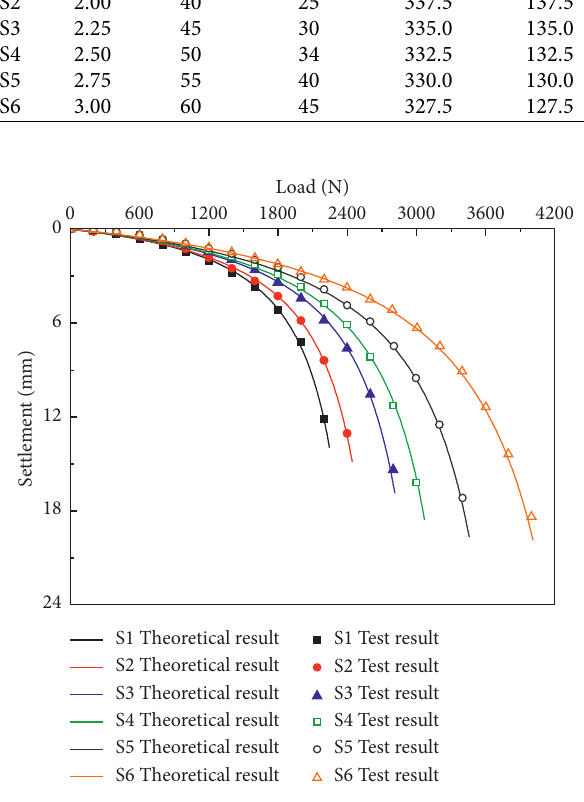
Figure 3: Comparison of P - s curves between test piles and method result.